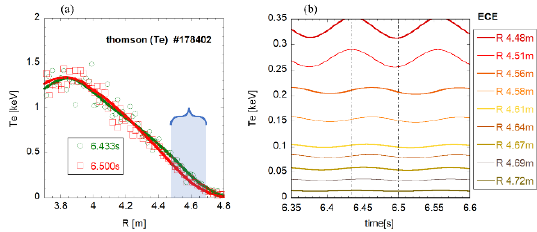
Fig. 13. (a) T e radial profiles measured by Thomson scattering. Green and red solid lines are obtained by fitting. (b) Time variation of electron temperature obtained by ECE in the region shown in blue in (a).